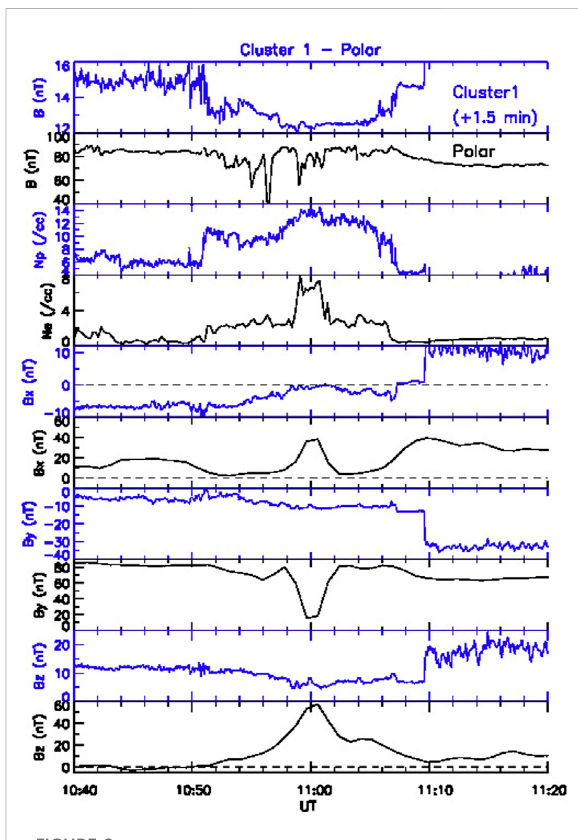
FIGURE 8 Polar (black traces) and Cluster 1 (blue) for the interval 10: 40 — 11:20 UT. Cluster 1 data have been time-shifted by 1.5 min to align the peaks of the density pro fi les in panels 3 and 4.